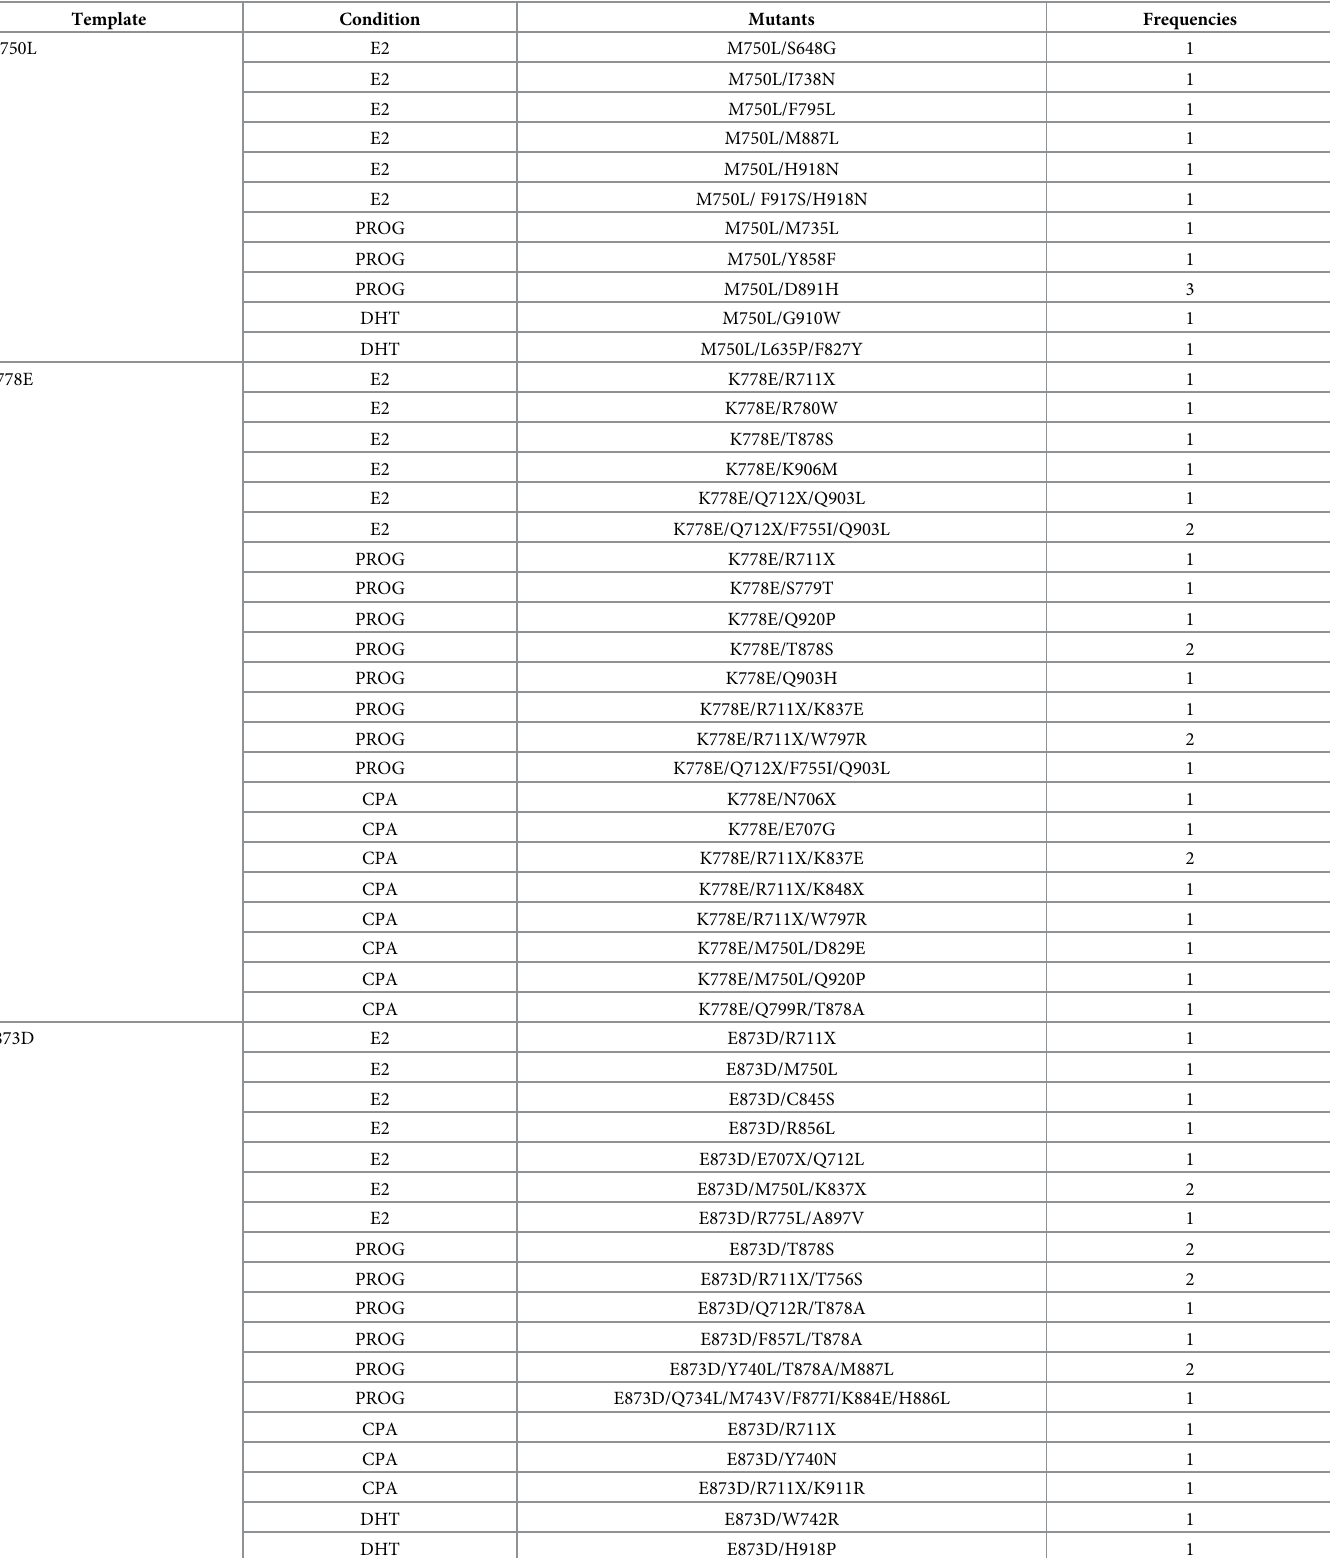
Table 3. Summary of sequenced AR mutations acquired in the secondary mutation